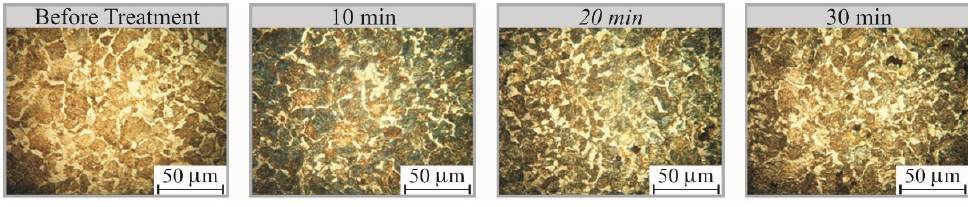
Figure 2. Dynamics of changes in the microstructure of 40Kh steel after ultrasonic treatment. Before treatment, it can be seen that 40Kh steel had a typical ferrite–pearlitic structure typical of hypoeutectoid steel. During the first 10 min of cavitation treatment, no changes occurred. The first signs of erosional damage appeared after 20 min of treatment. With further treatment up to 60 min, an increase in the number of erosion pits occurred, which formed at the grain boundaries. This can be explained by peculiarities of the distribution of the cavitation activity over the treated surface. Usually, the places of greatest impact are microrelief inhomogeneities, i.e., areas where more bubbles accumulate in the largest peaks and